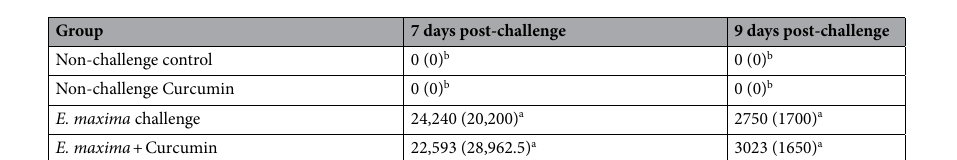
between the challenge control or chickens challenged with E. maxima and supplemented with curcumin at both times of evaluation (Table 3).